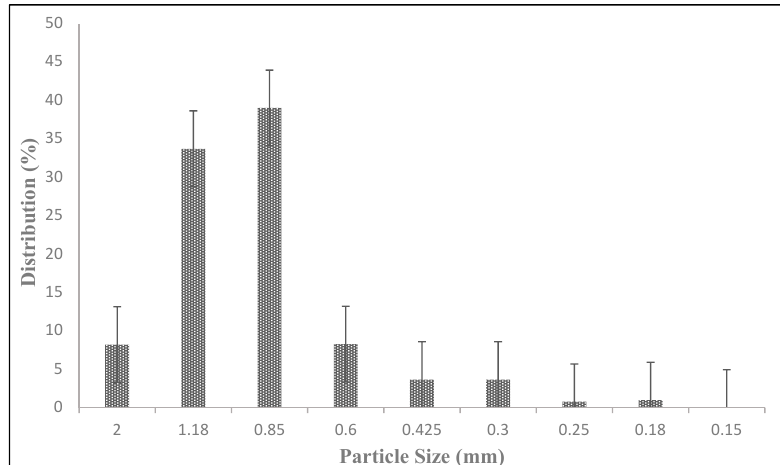
Figure 2. Particle size distribution (PSD) of the sawdust used in this study. The vertical axis gives the percent sawdust retained on each sieve.